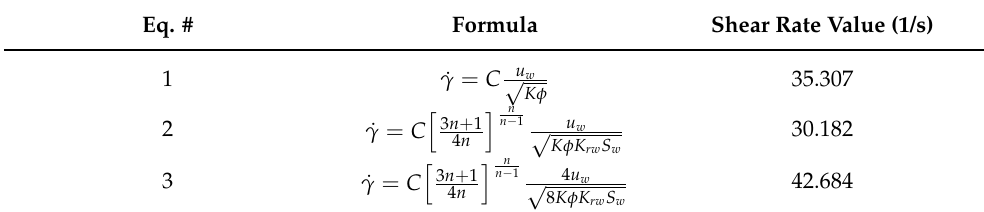
Table 3. Evaluation of shear-rate